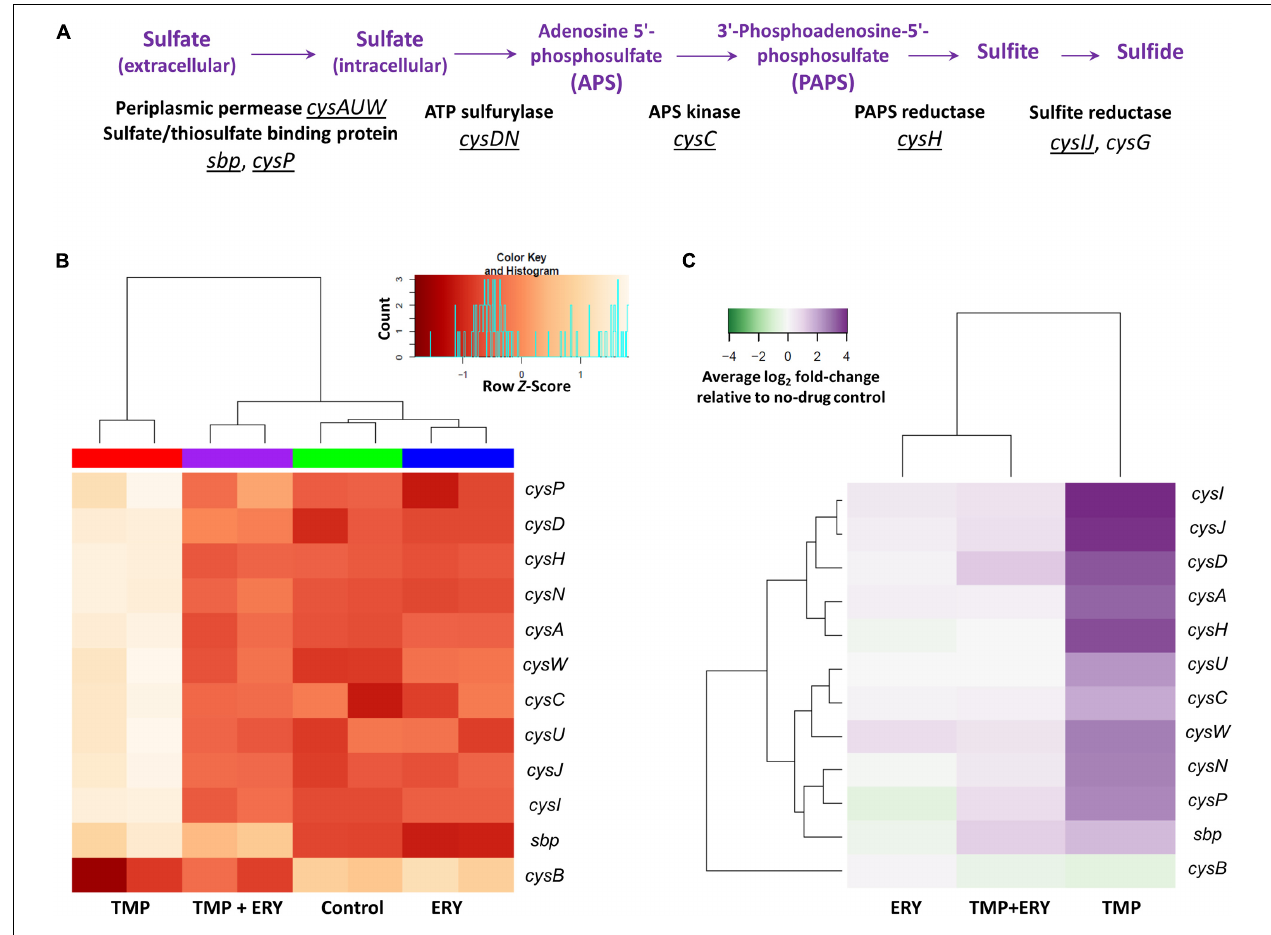
FIGURE 3 | Transcriptomic response of the assimilatory sulfate reduction pathway. (A) Genes and operons of the assimilatory sulfate reduction pathway. The underlined genes and operons were included in the two-way hierarchical clustering analysis. cysG was excluded from this analysis due to its different regulatory mechanism from all other genes in the sulfate reduction pathway. (B) The expression profiles of the sulfate reduction pathway follow the same trend as cysH and cysIJ . Two-way hierarchical clustering analysis for genes of the sulfate reduction pathway and their transcriptional regulator gene cysB . With the exceptions of cysB and sbp , all the cys genes in this pathway generally follow the same gene expression profiles as those of cysH and cysIJ across all the sample groups. (C) Average log 2 fold-change of sulfate reduction gene expression levels in the TMP, ERY and TMP + ERY groups relative to the no-drug control